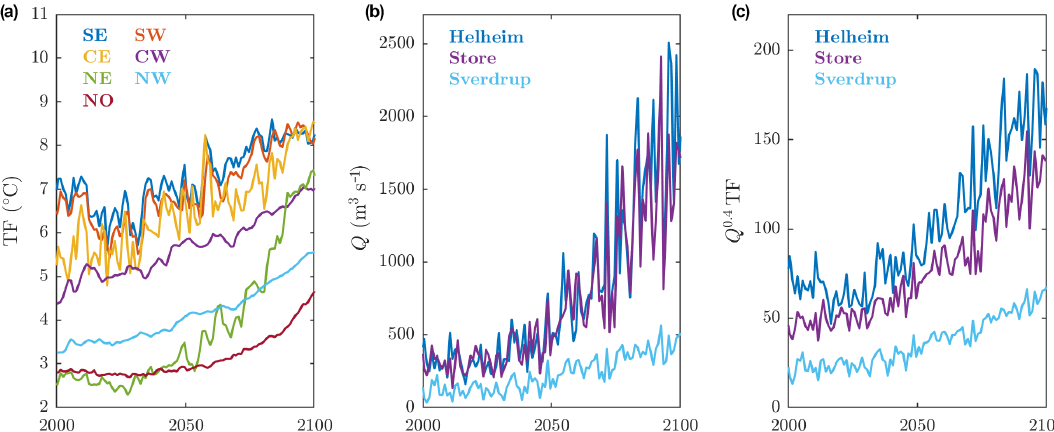
Figure 9. Projected RCP8.5 tidewater glacier climate forcing using the climate model MIROC5 and regional climate model MAR. (a) Ther- mal forcing (TF) from MIROC5 for each of the ice–ocean sectors. (b) Subglacial discharge ( Q ) for selected glaciers from a MAR simulation forced by MIROC5. (c) Parameterized submarine melting. The colors in (b) and (c) show the ice–ocean region to which the glacier